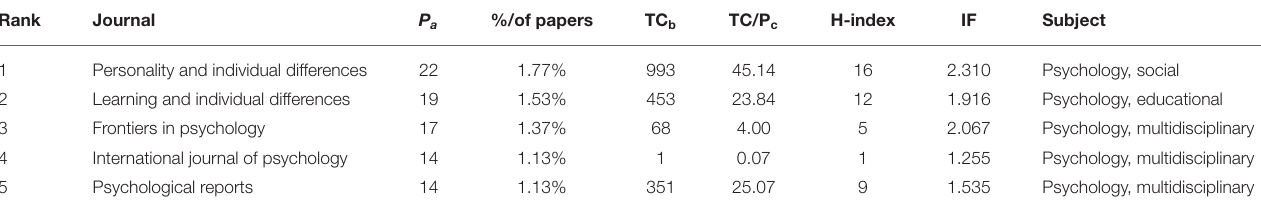
TABLE 6 | Top 5 productive journals in academic procrastination: 1938–2021. Rank Personality and individual